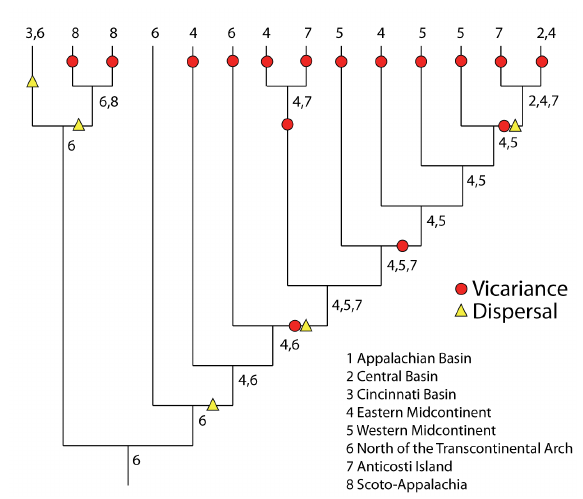
Fig. 2. Cladogram of evolutionary and biogeographic relation- ships for species in Eochonetes . Phylogenetic topology and geographic distributions from Bauer (2014). Biogeographic states for ancestral nodes were optimized using Fitch Parsimony as described in Lieberman